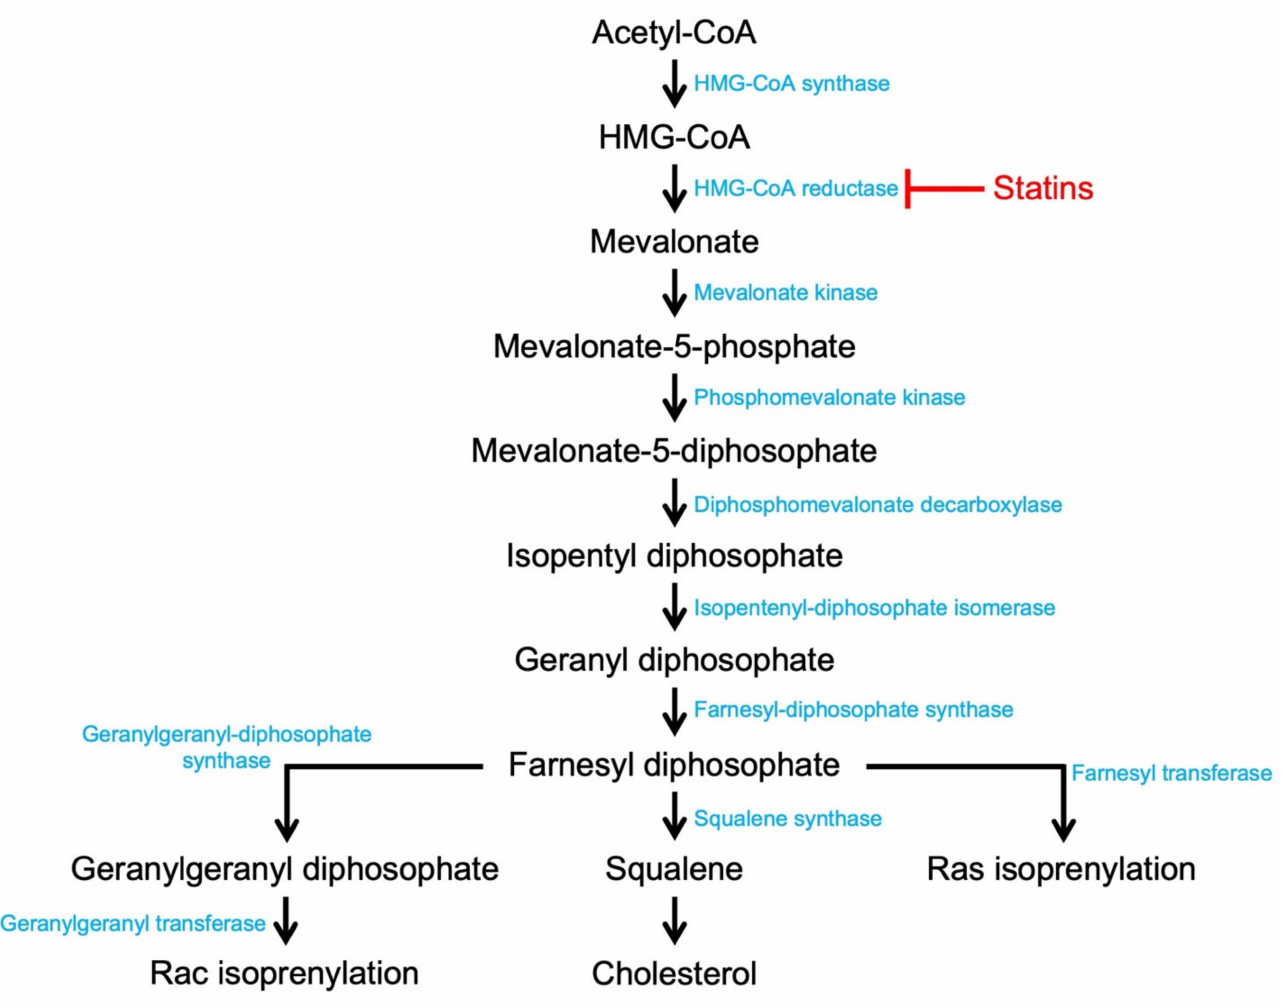
Figure 4. Statins disrupt the mevalonate pathway and consequent Rac isoprenylation. Illustration of the mevalonate pathway leading to the production of cholesterol and isoprenoids. Farnesyl diphosphate (FPP) and geranyl-geranyl diphosphate (GGPP) post-translationally modify the signaling proteins Ras and Rac, respectively. Statin inhibition (red) of HMG-CoA reductase disrupts both cholesterol synthesis and Rac isoprenylation upstream of the independent branch point of farnesyl